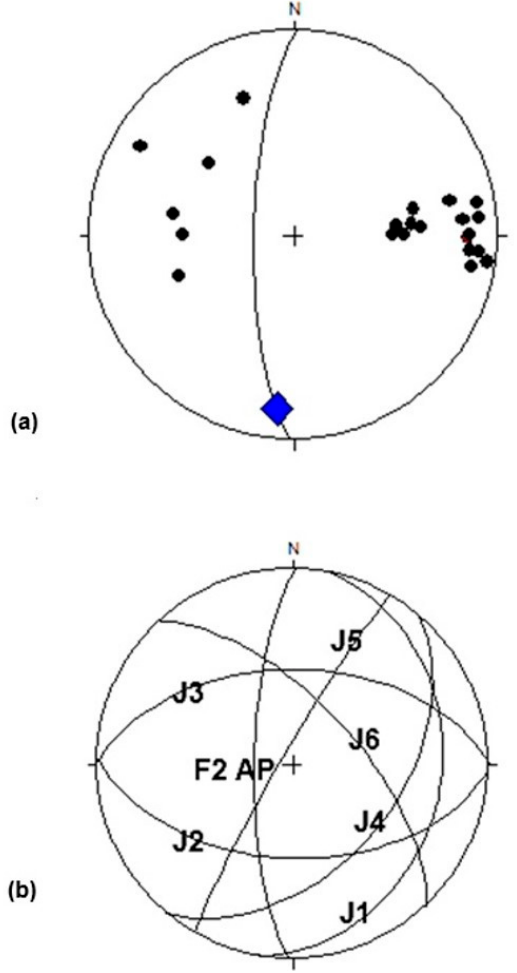
Figure 6. Stereographic projection diagrams (equal area, lower hemisphere) for orientation data of structural elements from the study area. ( a ) A synoptic plot of S 0 //S 1 poles. The blue-filled square indicates the pole to the best-fit girdle to the S 0 //S 1 poles and, therefore, indicates the orientation of the fold axis (16.1 ◦ → 185.7 ◦ ). The great circle indicates the orientation of the axial surface of the overturned F 2 fold. ( b ) Plot of joint planes of sets J1–J6 and the axial plane of F 2 fold (F 2 AP).